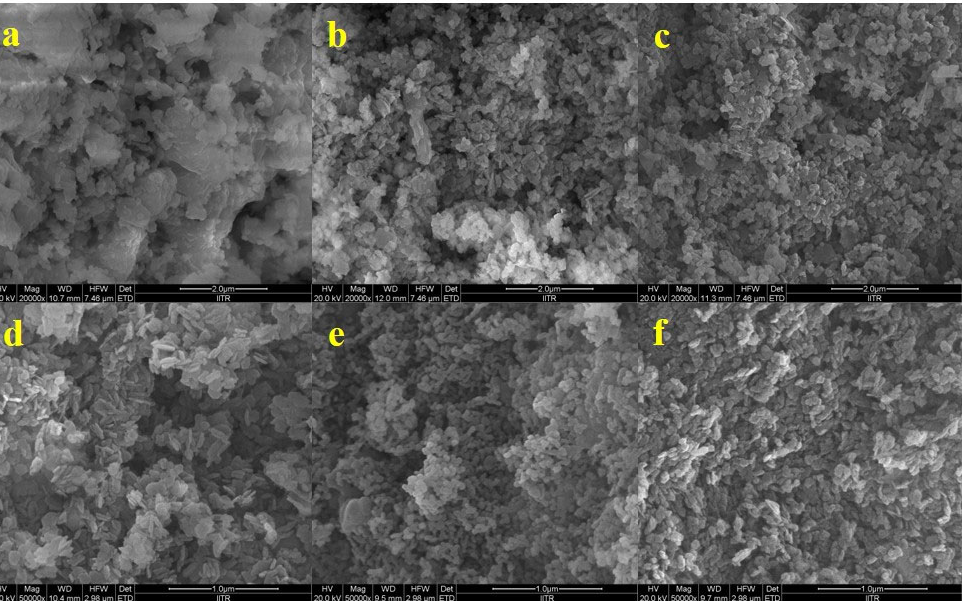
Figure 3. FE ‐ SEM images of Cao–MgO catalysts before and after calcination (( a ) MgCa 0.5 CNc, ( c ) MgCa 0.5 CN, and ( e ) Mg Ca 0.5 before calcination; ( b ) MgCa 0.5 CNc, ( d ) MgCa 0.5 CN, and ( f ) MgCa 0.5 CNa after calcination).